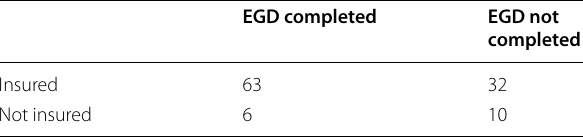
Table 1 63 of the 95 insured patients completed screening compared to 6 of the 16 uninsured patients, making for a 77% increase in screening completion among the insured patients (OR 3.28) p <